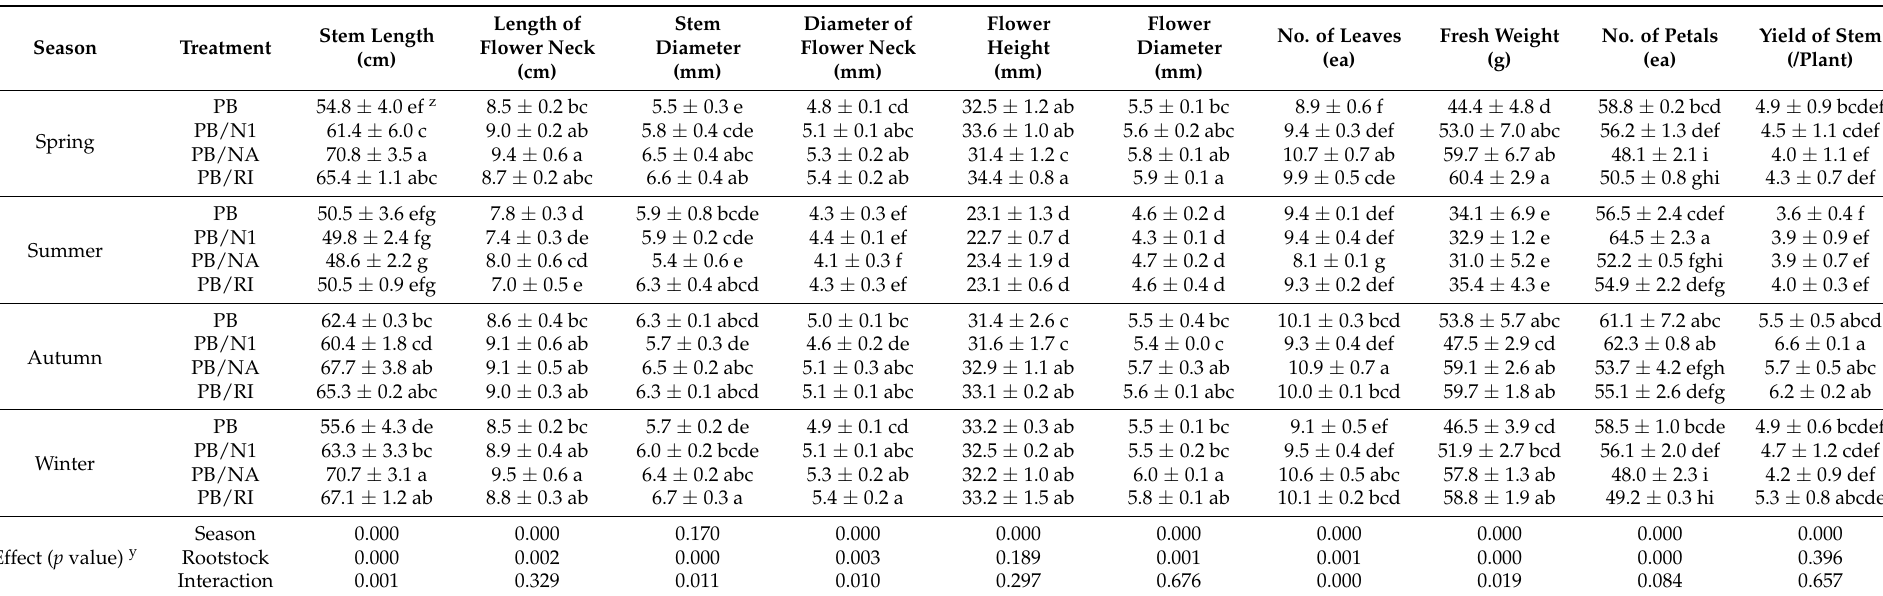
Table 1. The quality and yield of cut roses for Rosa hybrida cv. Pink Beauty (PB) and PB grafted onto Rosa multiflora cv. Hort. No. 1 (PB/N1), PB grafted onto Rosa canina cv. Natal brier (PB/NA), and PB grafted onto Rosa indica cv. Major (PB/RI) in four seasons